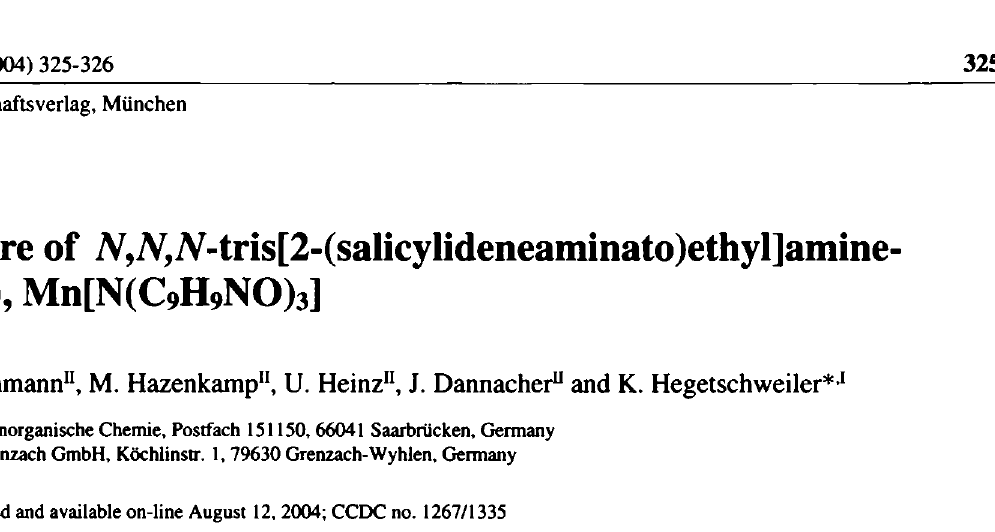
Table 1. Data collection and handling.